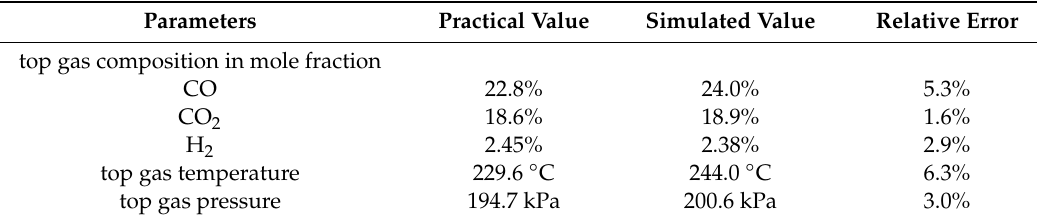
Table 3. Comparison between practical values and simulated values.